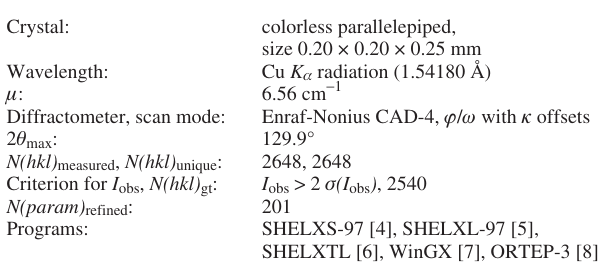
Table 1. Data collection and handling.